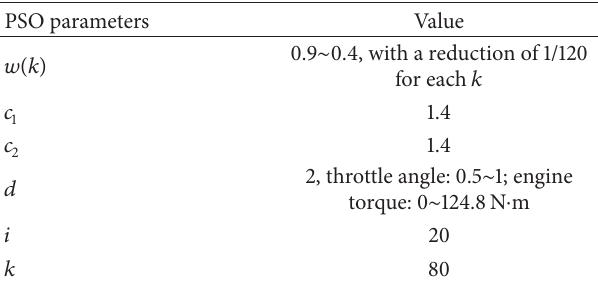
Table 3: Parameters in